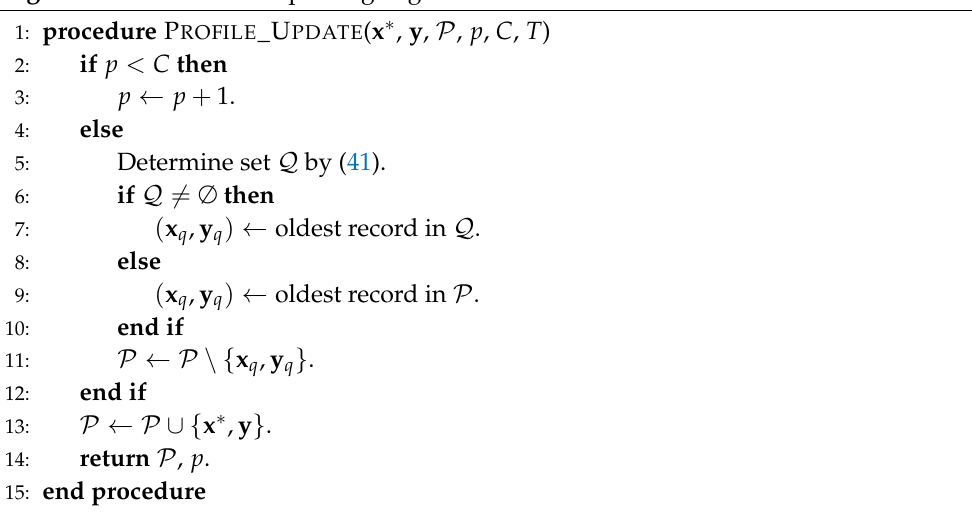
Algorithm 2 The Profile Updating